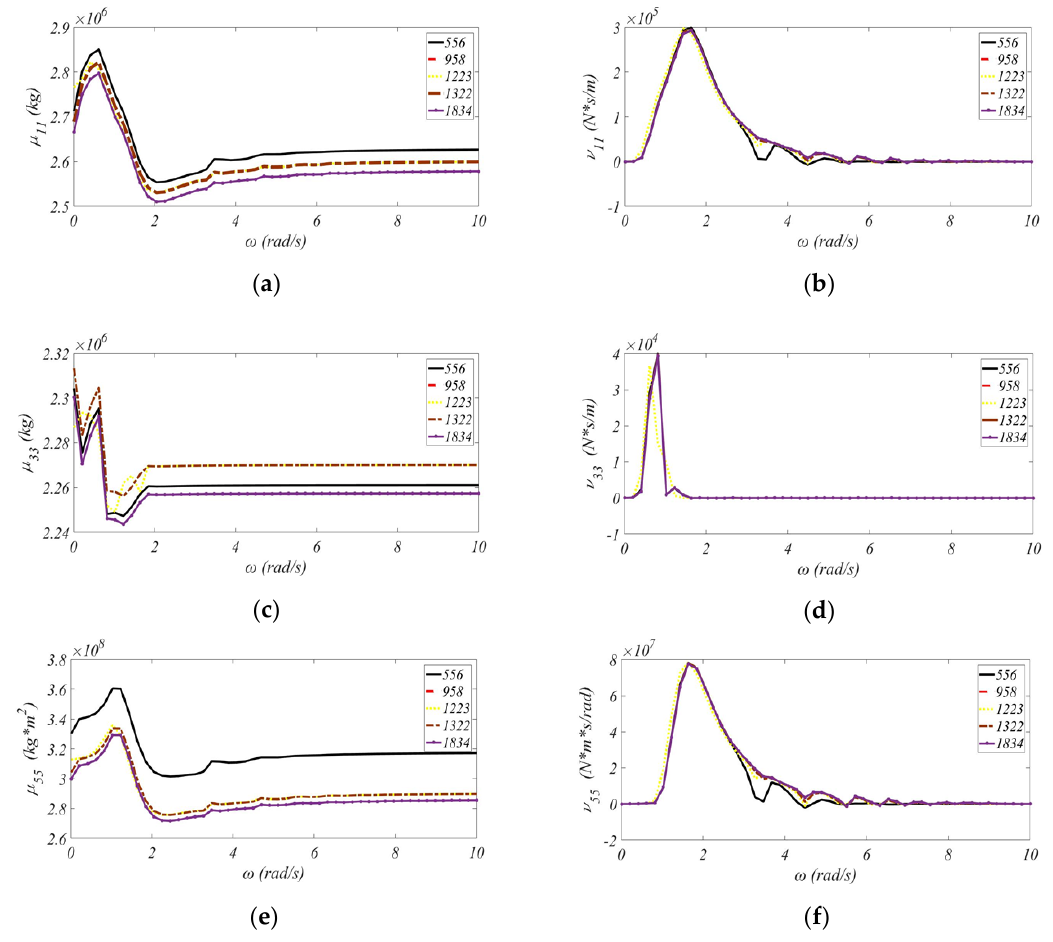
Figure 14. The mesh convergences for hydrodynamic coefficients ( a ) µ 11 ; ( b ) ν 11 ; ( c ) µ 33 ; ( d ) ν 33 ; ( e ) µ 55 ;